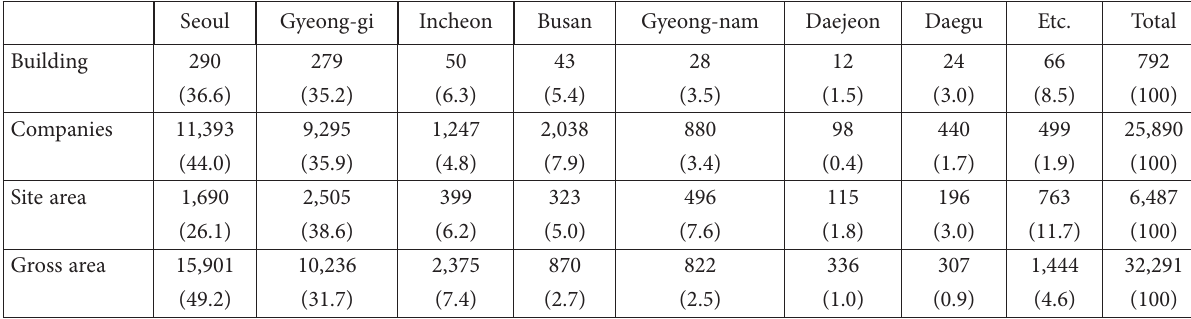
Table 3. Number of flatted factories (Nationwide) (source: Kim,